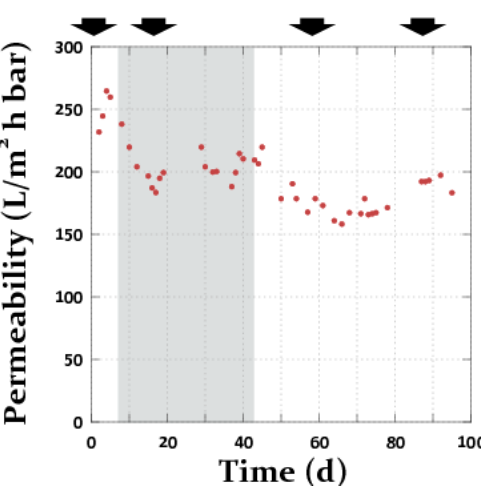
Figure 5. Membrane temperature corrected (20 °C) permeability. Data obtained during MBR acclimatization period; the arrows indicate sample collection time points for metagenomic analysis; the shaded area indicates the time period when both CSW and TOPW were fed to the MBR, CSW, and TOPW were solely fed before and after this period, respectively.